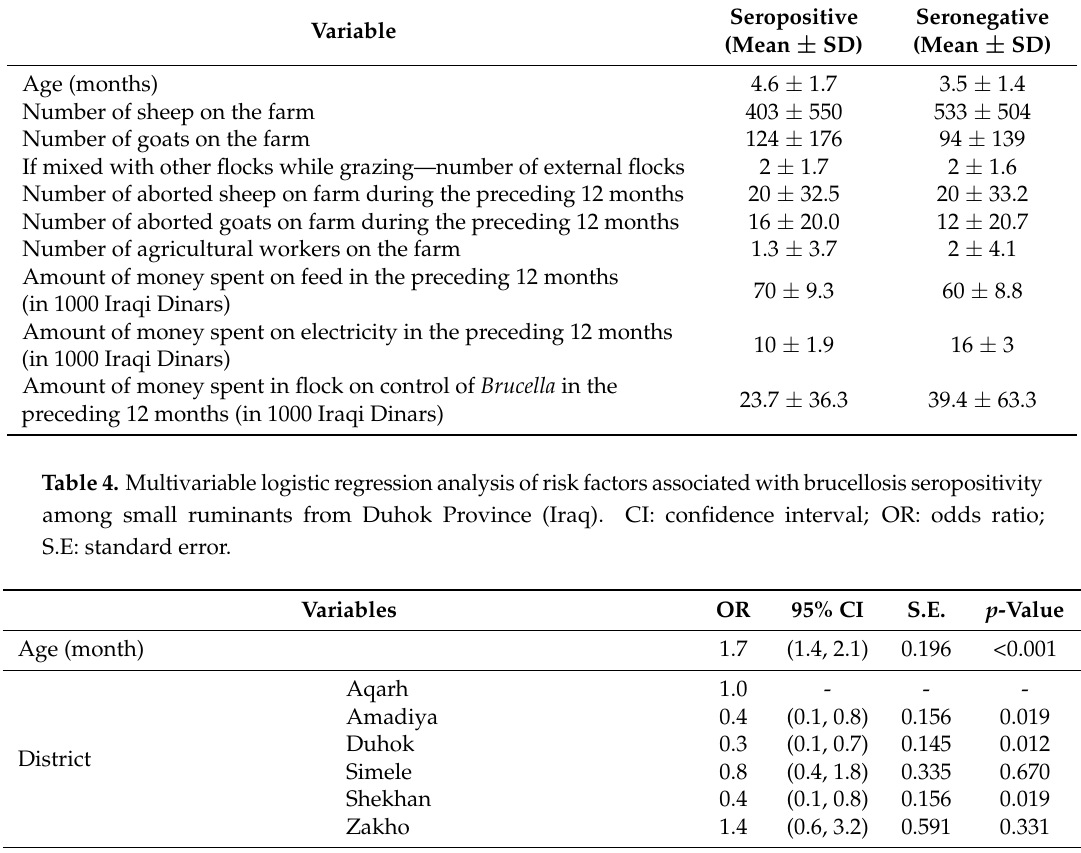
Table 3. Continuous risk factors associated with brucellosis seropositivity among small ruminants from Duhok Province (Iraq) using a parallel interpretation of the Rose Bengal test (RBT) and indirect enzyme-linked immunosorbent assay (iELISA).